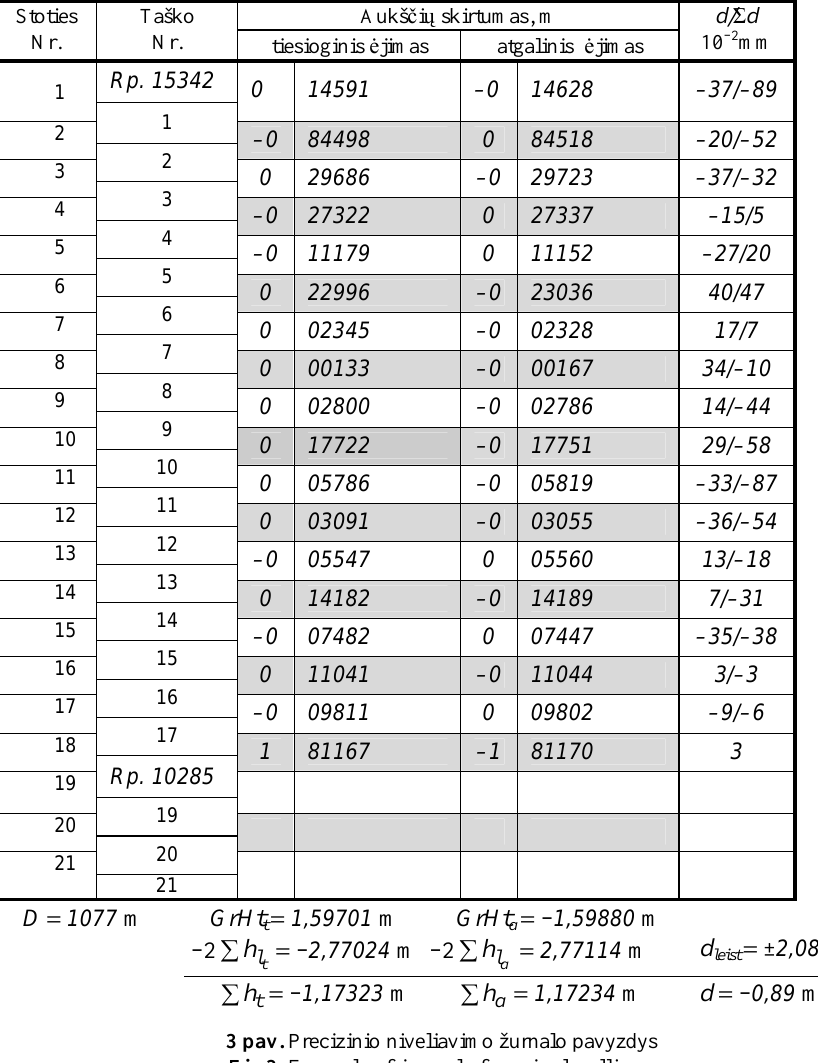
Fig 3. Example of journal of precise